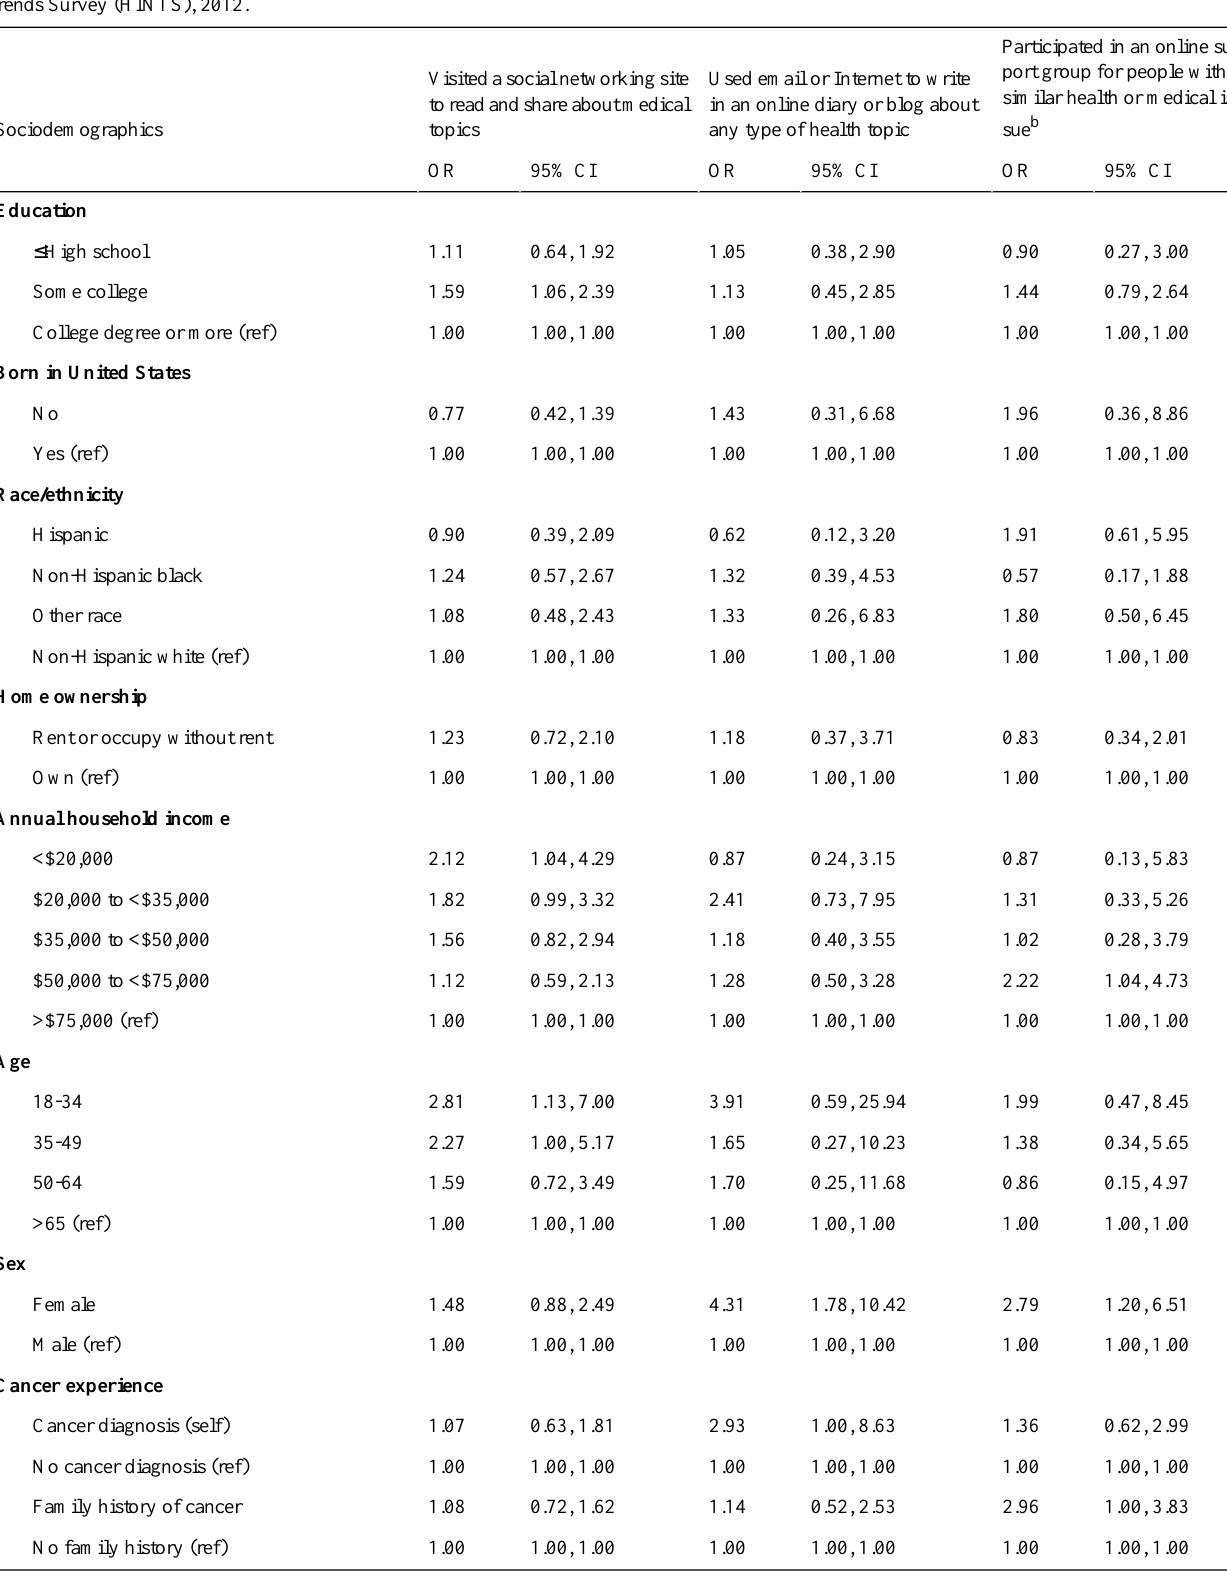
Table 5. Multivariable logistic regression models for odds a of reporting yes to eHealth usage, by SES and race/ethnicity, Health Information National Trends Survey (HINTS),